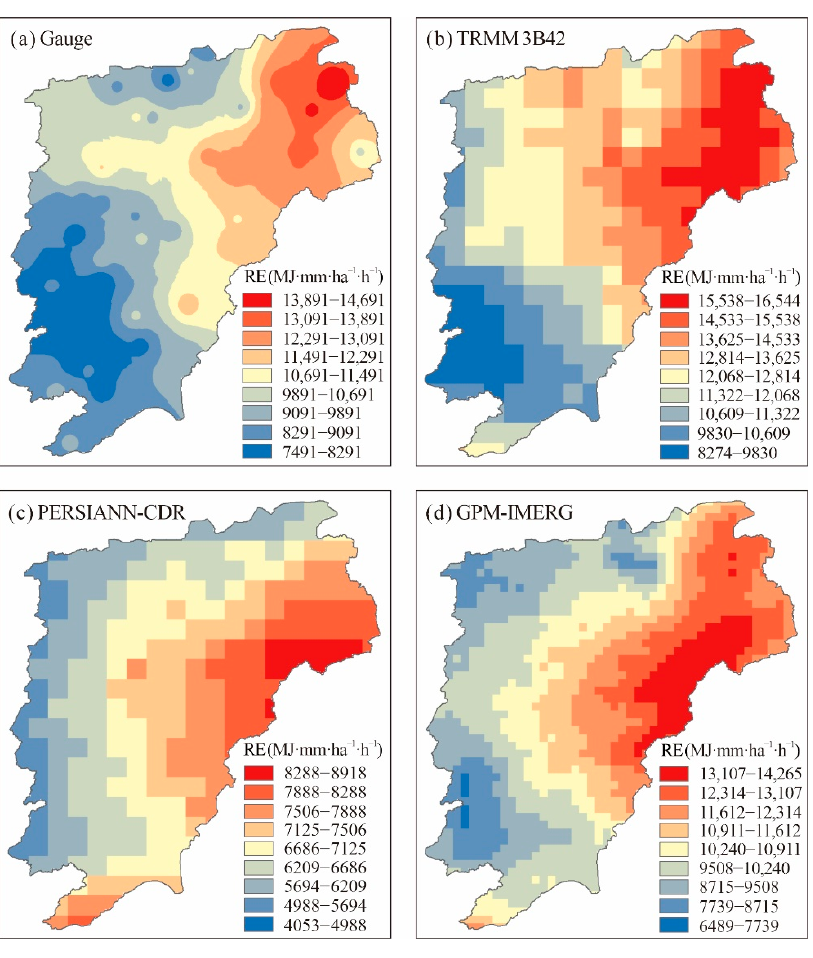
Figure 9. Comparison of the spatial patterns of average annual rainfall erosivity.